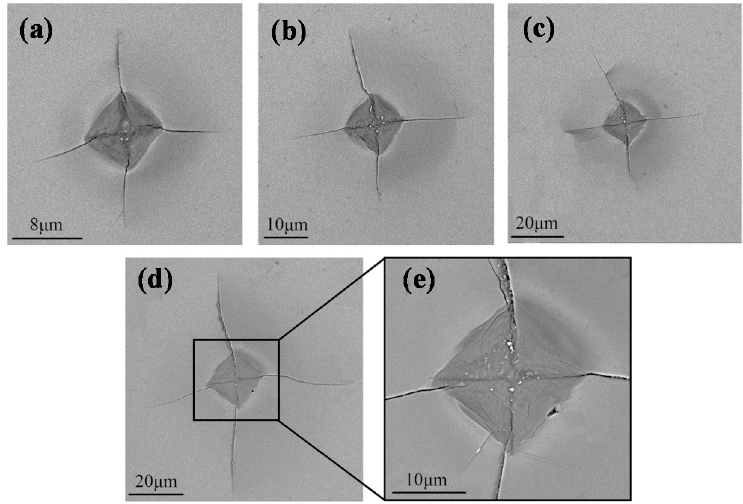
Figure 8. SEM images of C-plane sapphire for ( a ) 2 μ m, ( b ) 4 μ m, ( c ) 6 μ m, and ( d ) 8 μ m depth indentations, and ( e ) the enlarged detail of the selected region in ( d ).